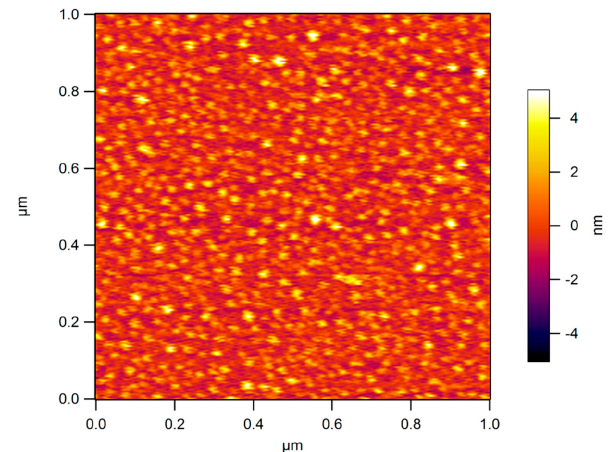
Figure 24. Height profile from tapping mode AFM under water for radiation-synthesized PVP nanogels modified with acrylic acid. The color scale represents a maximum height of 8 nm. Reproduced from [292].